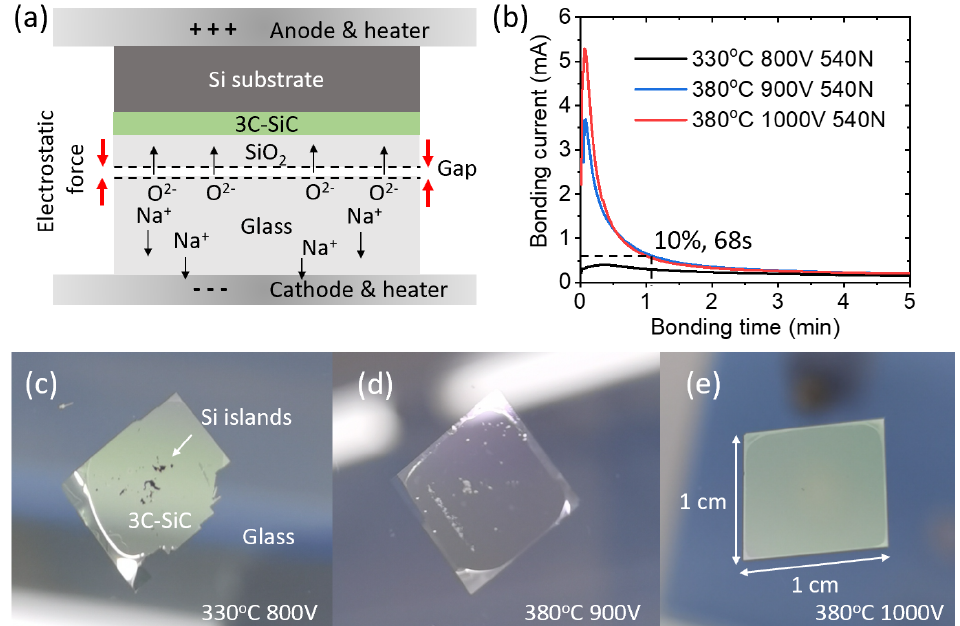
Figure 1. ( a ) An illustration of the principle of the anodic bonding process applied to 3C-SiC on a glass substrate. ( b ) Measured total bonding currents flowing through four 1 × 1 cm 2 3C-SiC dies during the bonding process under different conditions. ( c – e ) Successfully transferred 3C-SiC films on glass substrates after Si substrate removal under different process conditions. The remaining Si islands could be readily removed by wet-etching using mixed acid solutions.